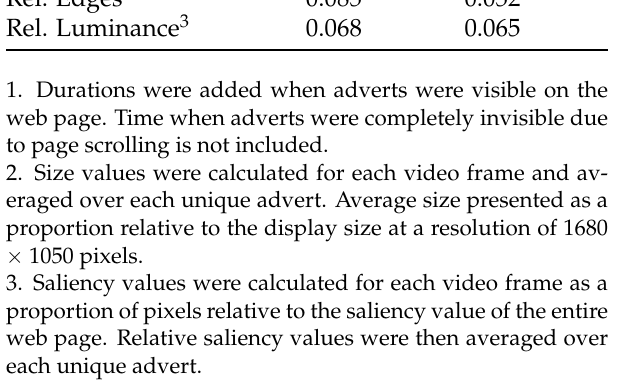
Figure 2 . The figure shows the proportion of correct anti- saccades by gender.